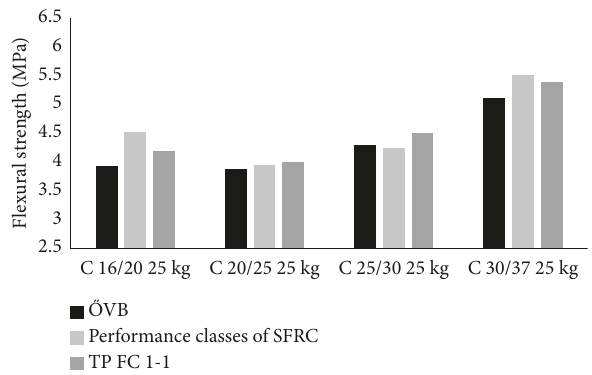
Figure 4: Bending strength of SFRC—amount of fibers: 25kg/m 3 .